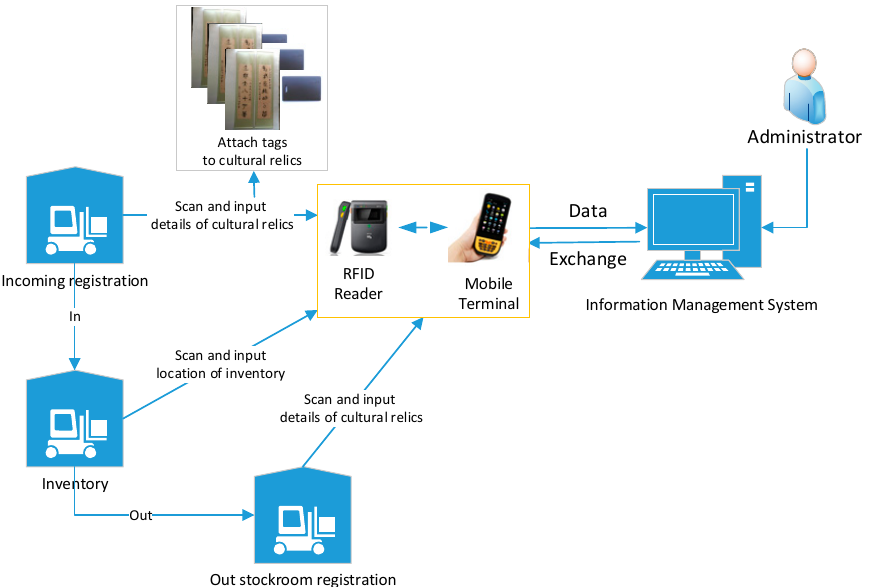
Figure 7. RFID-based identification and management of cultural relics.